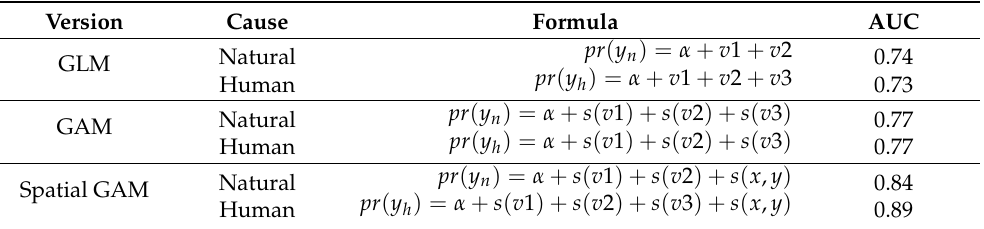
Table 1. Summary of the multiple logistic general linear model (GLM), the general additive model (GAM), and spatial-GAM. Formulas are presented for modeling the probability of a natural ignition, pr ( y n ) , and human-caused ignition, pr ( y h ) , where α is the intercept, v 1 = slope, v 2 = maximum NDVI, v 3 = distance to roads, x = longitude, and y = latitude. The s () functions indicate the smoothed terms in the GAMs. The area under the receiver operating characteristic (ROC) curve (AUC) is based on the testing data, and the ROCs themselves are shown in Figures 5 and 6, respectively. Version Cause Formula AUC GLM